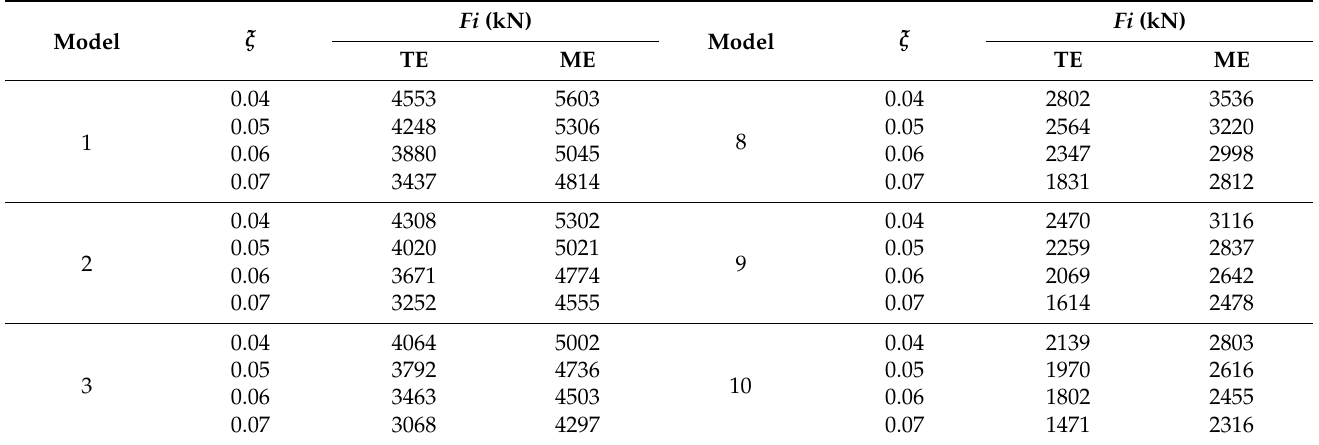
Figure 10. Ground surface SA of the ME waveform. The values of the inertial forces in Scenario 1 based on the TE and ME waveforms are shown in Table 3. The ME waveform produced a more significant inertial force than the TE waveform due to its larger SA for the PSW’s natural period. Table 3. Inertial forces for Scenario 1.